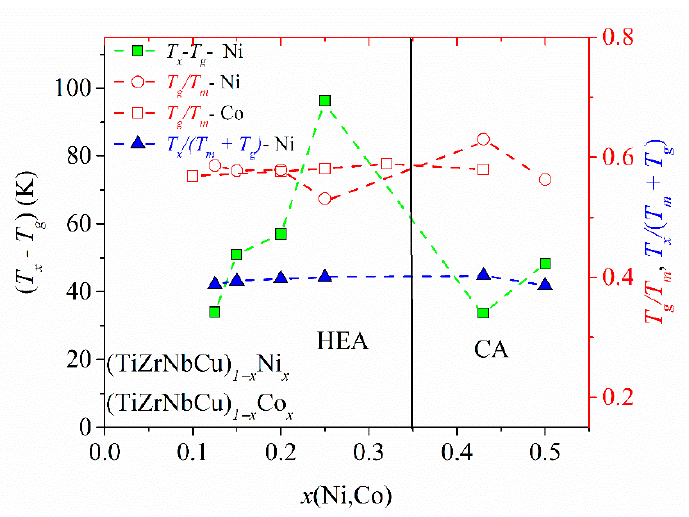
Figure 7. Glass-forming ability parameters of (TiZrNbCu) 1 − x Ni x and (TiZrNbNi) 1 − x Co x alloys vs. x .